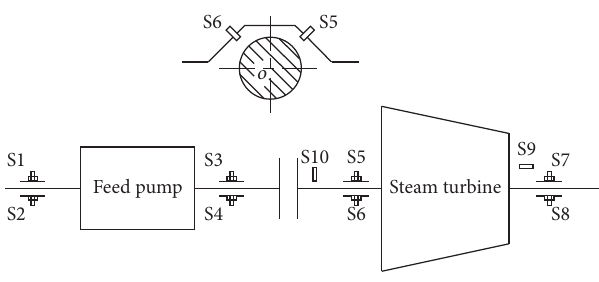
Figure 6: Layout of vibration measuring